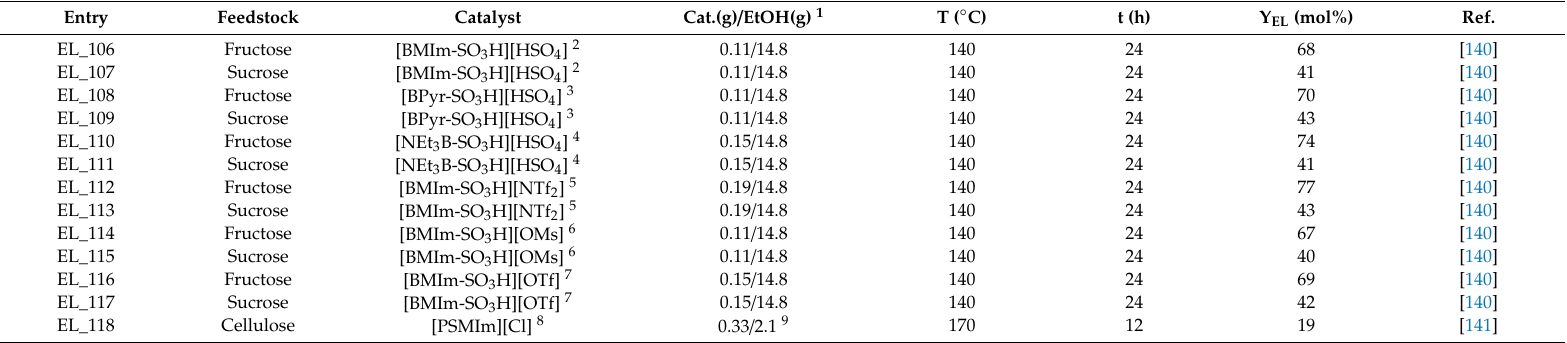
Table 12. Ionic liquid catalysts for the EL production from C6 model carbohydrates, under conventional